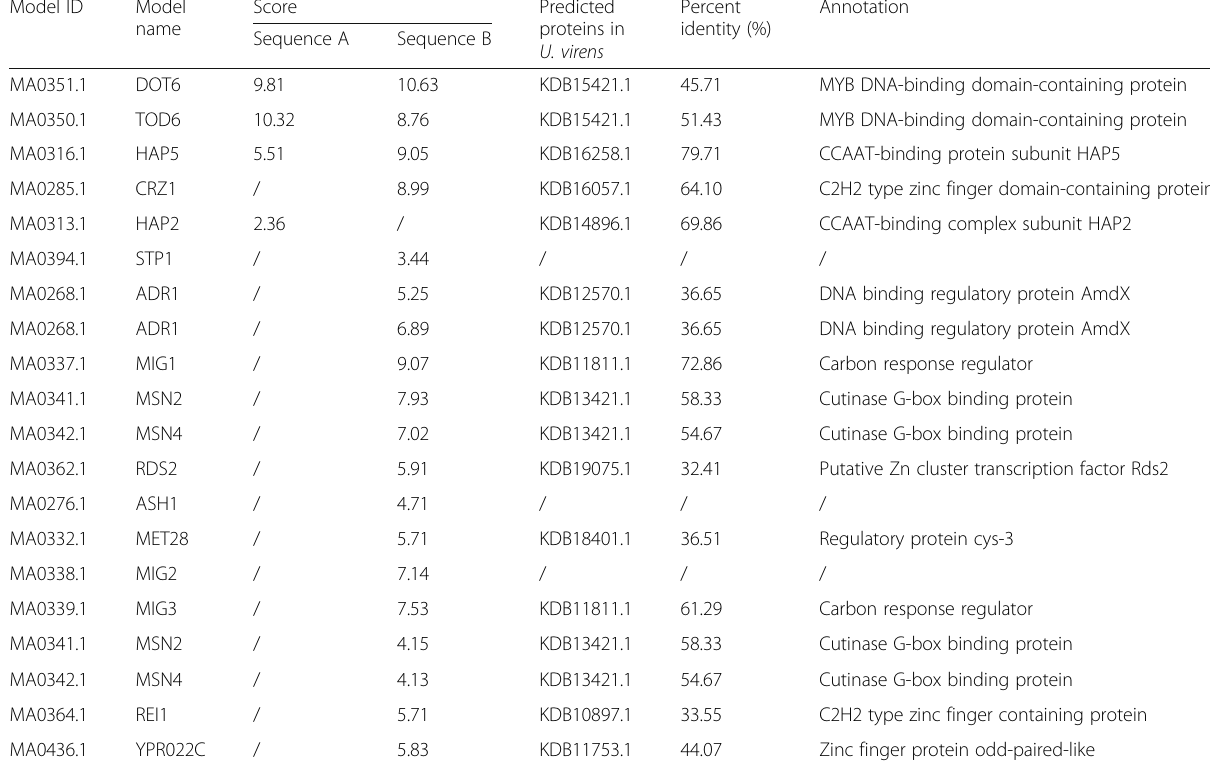
Table 5 Differential functional binding sites predicted in the non-coding region upstream of CYP51 in U. virens with ‘ CC ’ insertion mutations (sequence B) relative to that without ‘ CC ’ insertion (sequence A) using the JASPAR